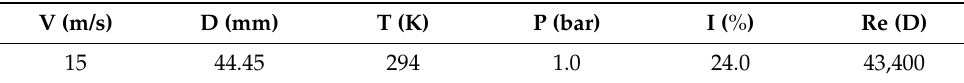
Table 1. Combustor